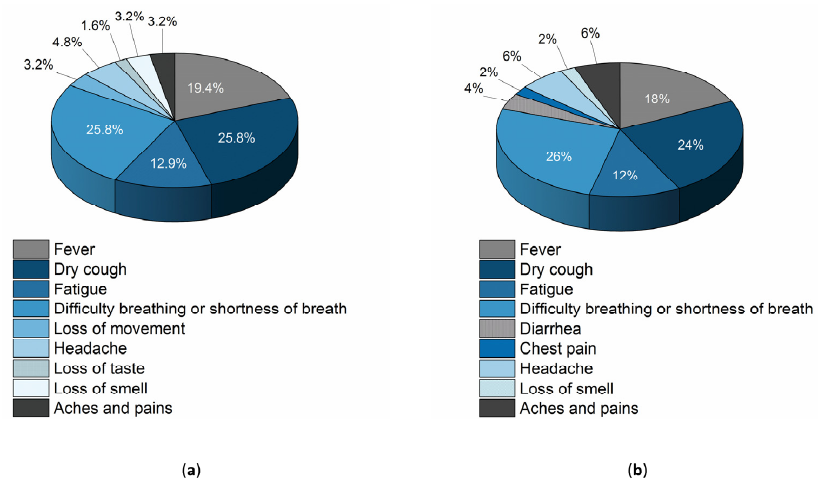
Figure 2. Symptomatology reported by study patients before hospitalization: ( a ) patients who re- mained with the device for 4 or 7 days and ( b ) patients who required invasive ventilation (intubation).